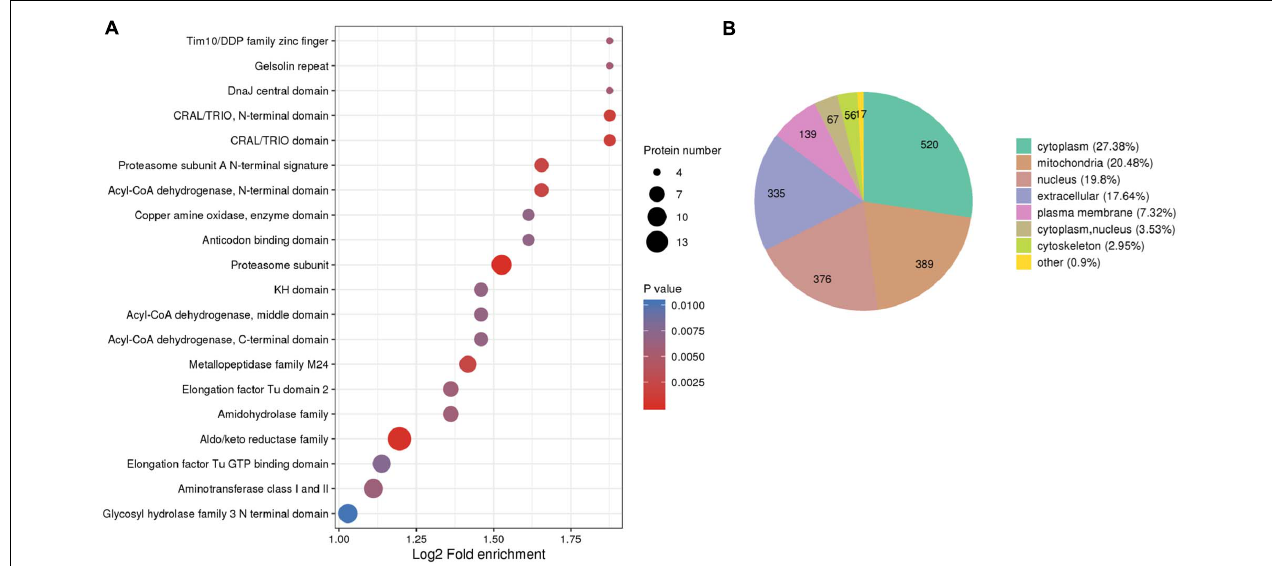
FIGURE 2 | Protein domain enrichment and subcellular localization of the identified thiol proteins. (A) Protein domain enrichment bubble plot of proteins corresponding to modification sites. (B) Subcellular localization chart of proteins corresponding to modification sites.